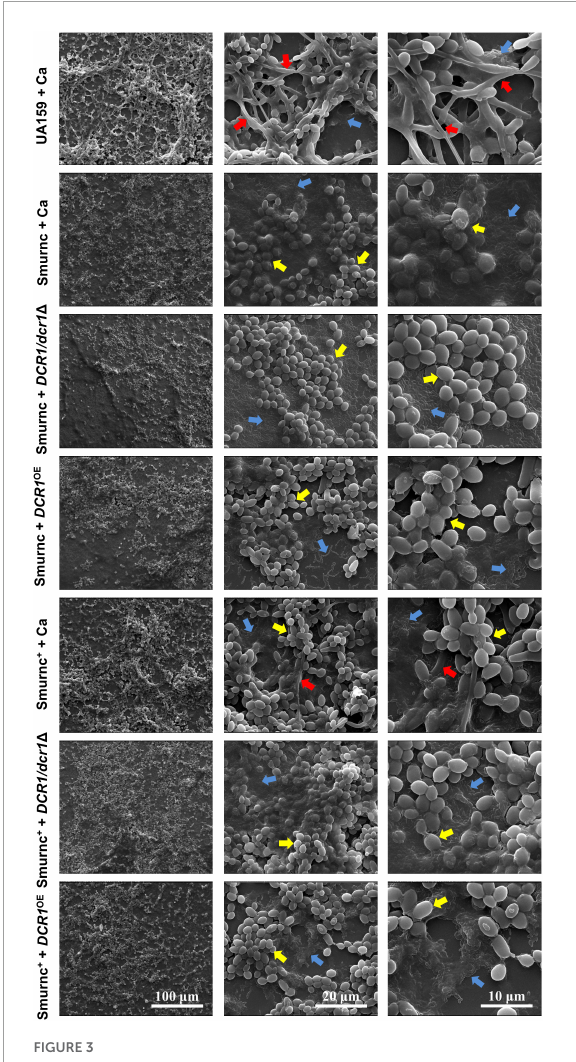
FIGURE3 The effects of genes coding RNase III on the architecture of cross-kingdom biofilms were observed by SEM. Blue arrows, S. mutans ; red arrows, C. albicans hyphae; yellow arrows, C. albicans yeast cells. All images were taken at 1,000 × (scale bar, 100 µ m), 5,000 × (scale bar, 20 µ m), and 10,000 × (scale bar, 10 µ m) magnifications,